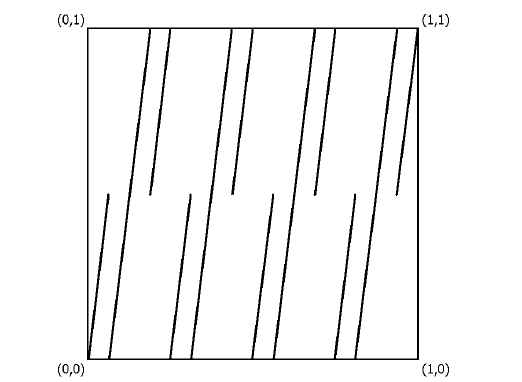
Figure 1. The graph of E 2